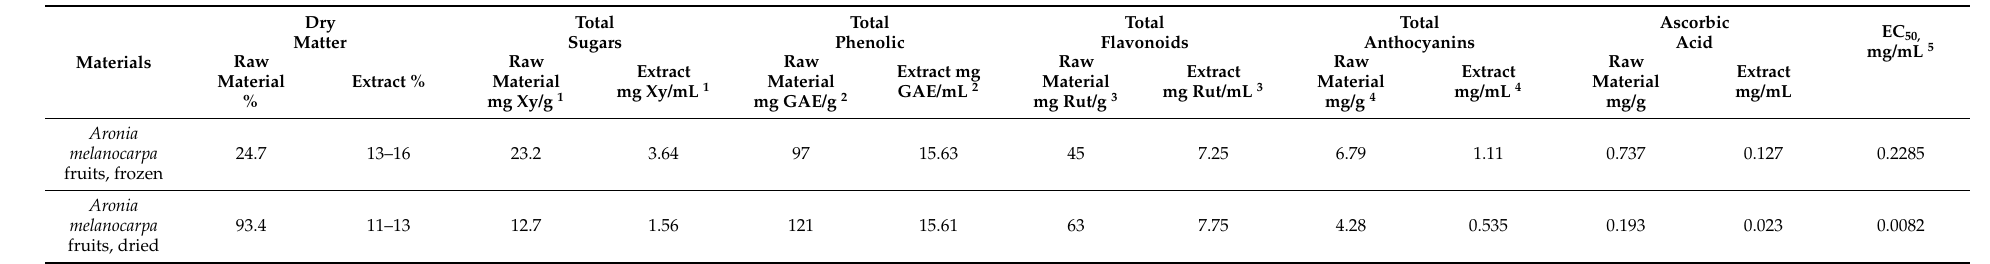
Table 1. Natural antioxidant content and DPPH radical scavenging activity in the original raw material and propylene glycol extracts of A. melanocarpa (per dry matter). 1 —Total